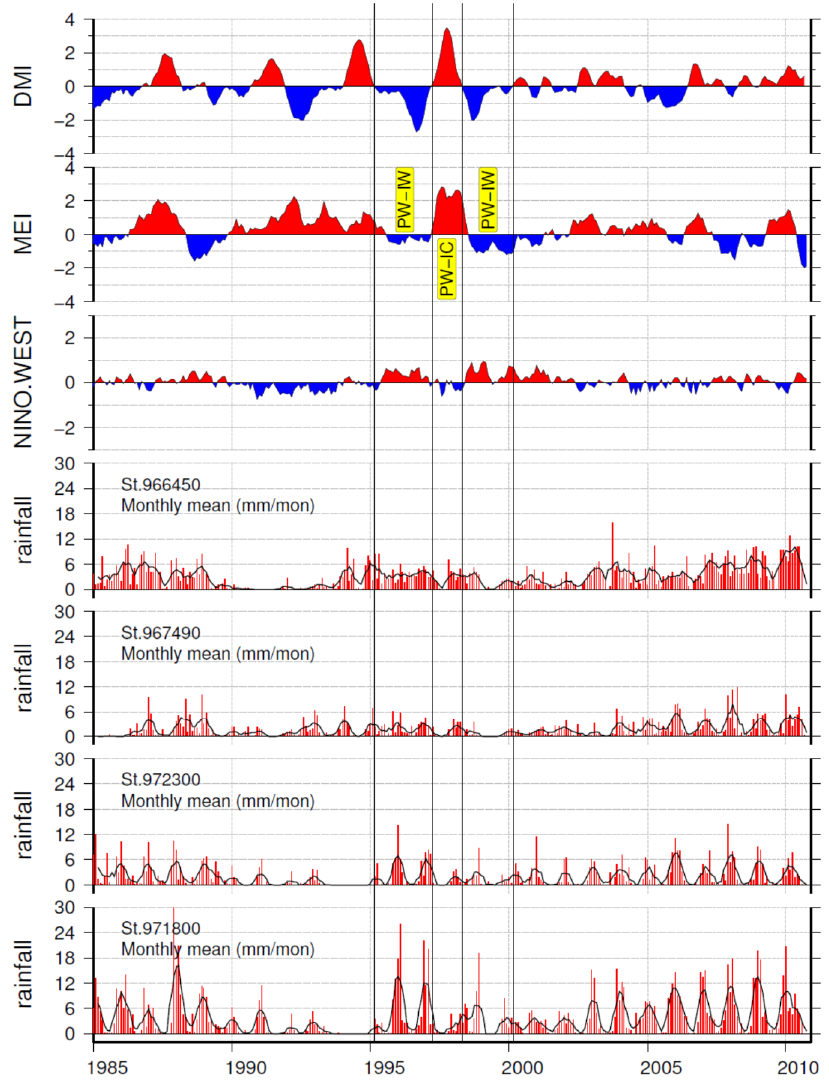
Figure 7. Comparisons of the time series of the mean daily rainfall for each month (red bars), the five-month running mean of the mean daily rainfall for each month in central Indonesia (black solid line) and the DMI, MEI, and NINO.WEST indices. See Figure 1a for the locations of the